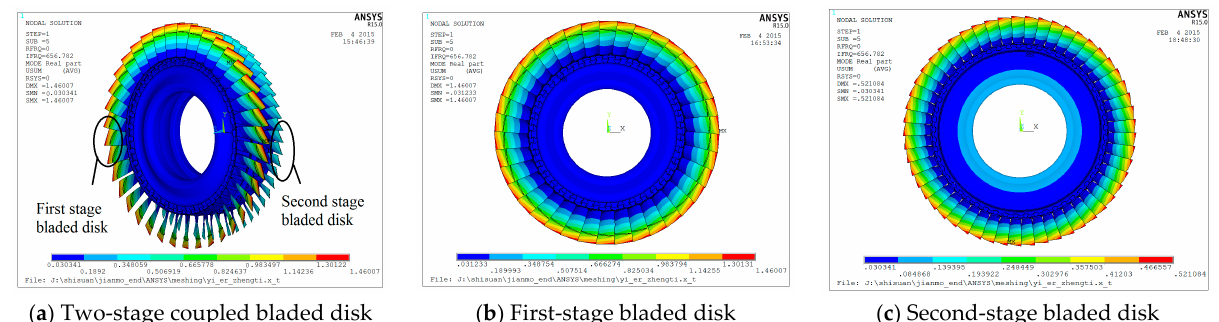
Figure 24. Four-pitch coupled vibration of the blade and disk.